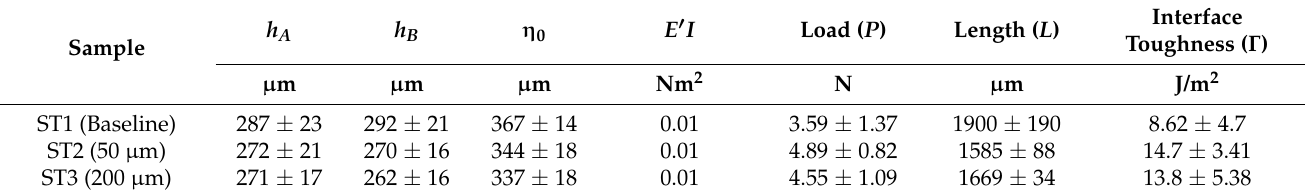
Table 3. Measured displacement, load, notch length and calculated interface toughness for all sample types.